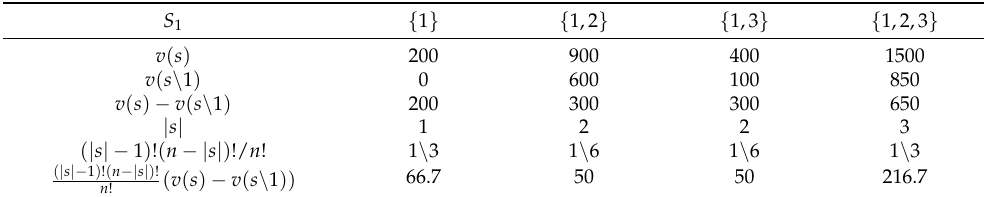
Table 2. Profit distribution of logistics enterprise 1 based on Shapley value